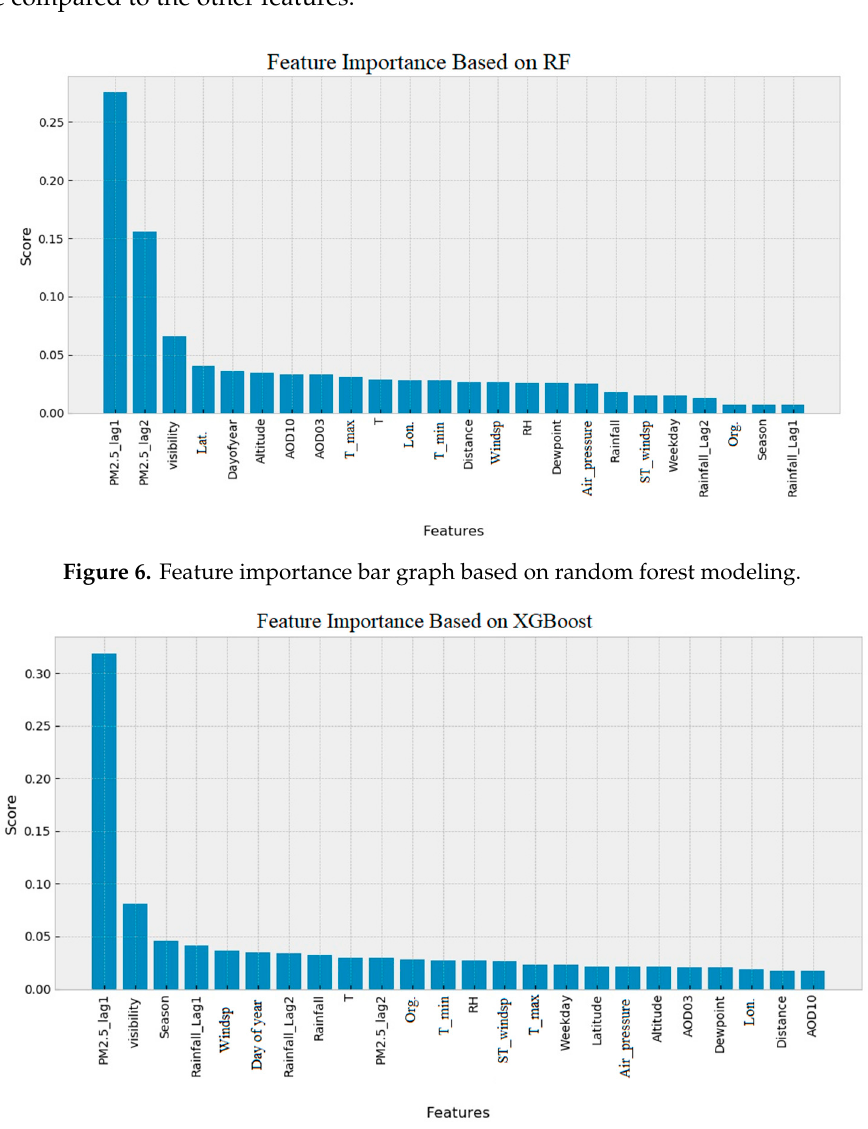
Figure 7. Feature importance bar graph based on the XGBoost feature importance built ‐ in function.